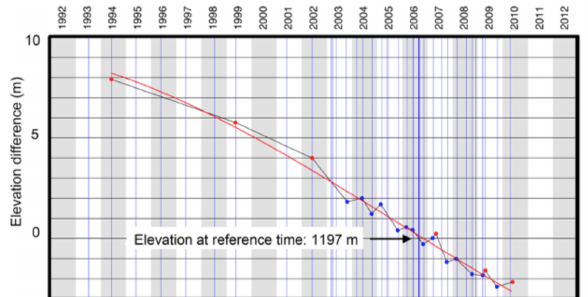
Figure 5. SERAC elevation time series illustrating the fusion of ICESat (blue dots) and ATM (red dots) altimetry data from the Jakobshavn drainage basin, West Greenland. The good agree- ment between the elevations derived from ICESat and ATM ob- servations confirms the excellent accuracy of the laser systems.